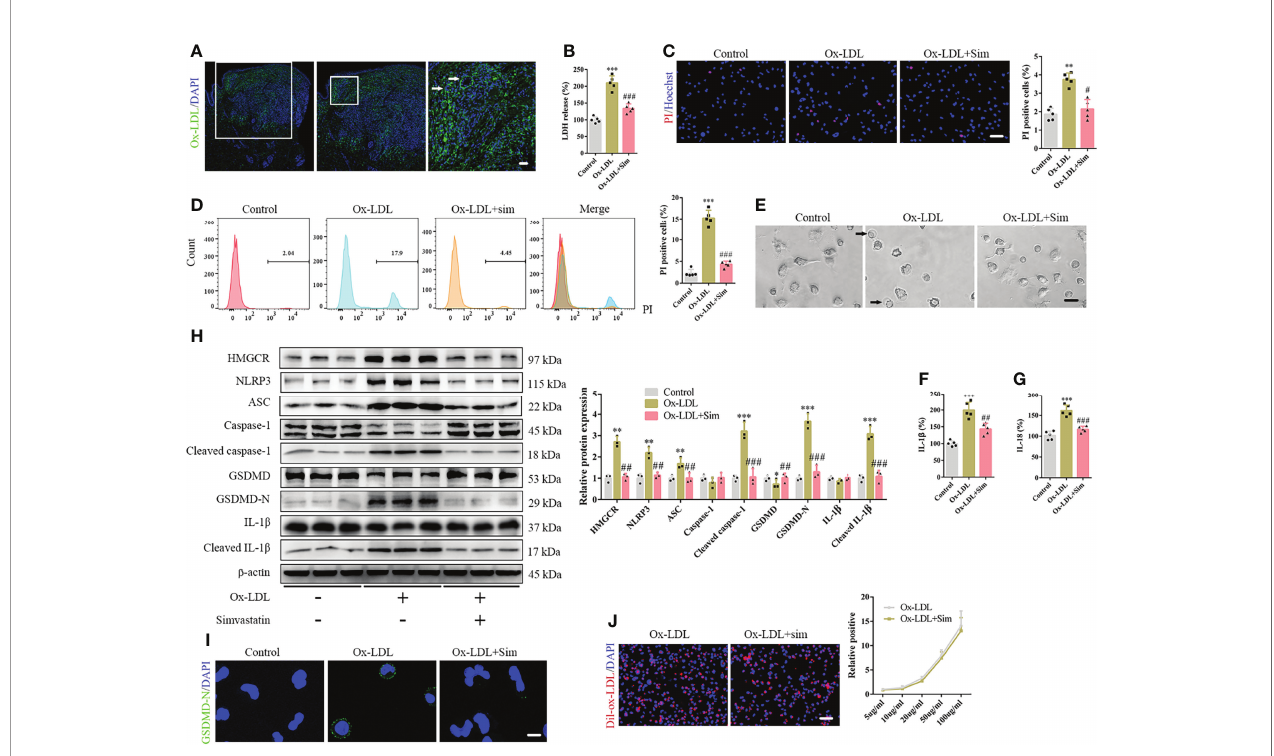
FIGURE 2 | Simvastatin inhibits the classical pyroptotic pathway in foam cells. (A) A large amount of oxidized low-density lipoprotein (ox-LDL) is deposited in the cytoplasm of the upper dermis, and Touton giant cells were observed (arrow). (B) Lactate dehydrogenase release in the cell supernatants. (C) Hoechst 33342 (blue) and propidium iodide (red) fl uorescence staining showing cell membrane integrity. Scale bar, 100 m m. (D) Flow cytometry for the detection of pyroptotic cells. (E) Pyroptotic bubbles (arrow) were observed under the microscope. Scale bar, 25 m m. (F, G) Results of enzyme-linked immunosorbent assay for determining IL-1 b and IL-18 levels in the cell supernatants. (H) Western blotting showing protein abundance. (I) Immuno fl uorescence staining showing GSDMD-N expression activation. Scale bar, 12.5 m m. (J) Macrophage phagocytosis of Dil-ox-LDL. Scale bar, 100 m m. **p < 0.01, ***p < 0.001, versus the control. # p < 0.05, ## p < 0.01, ### p < 0.001, versus the ox-LDL